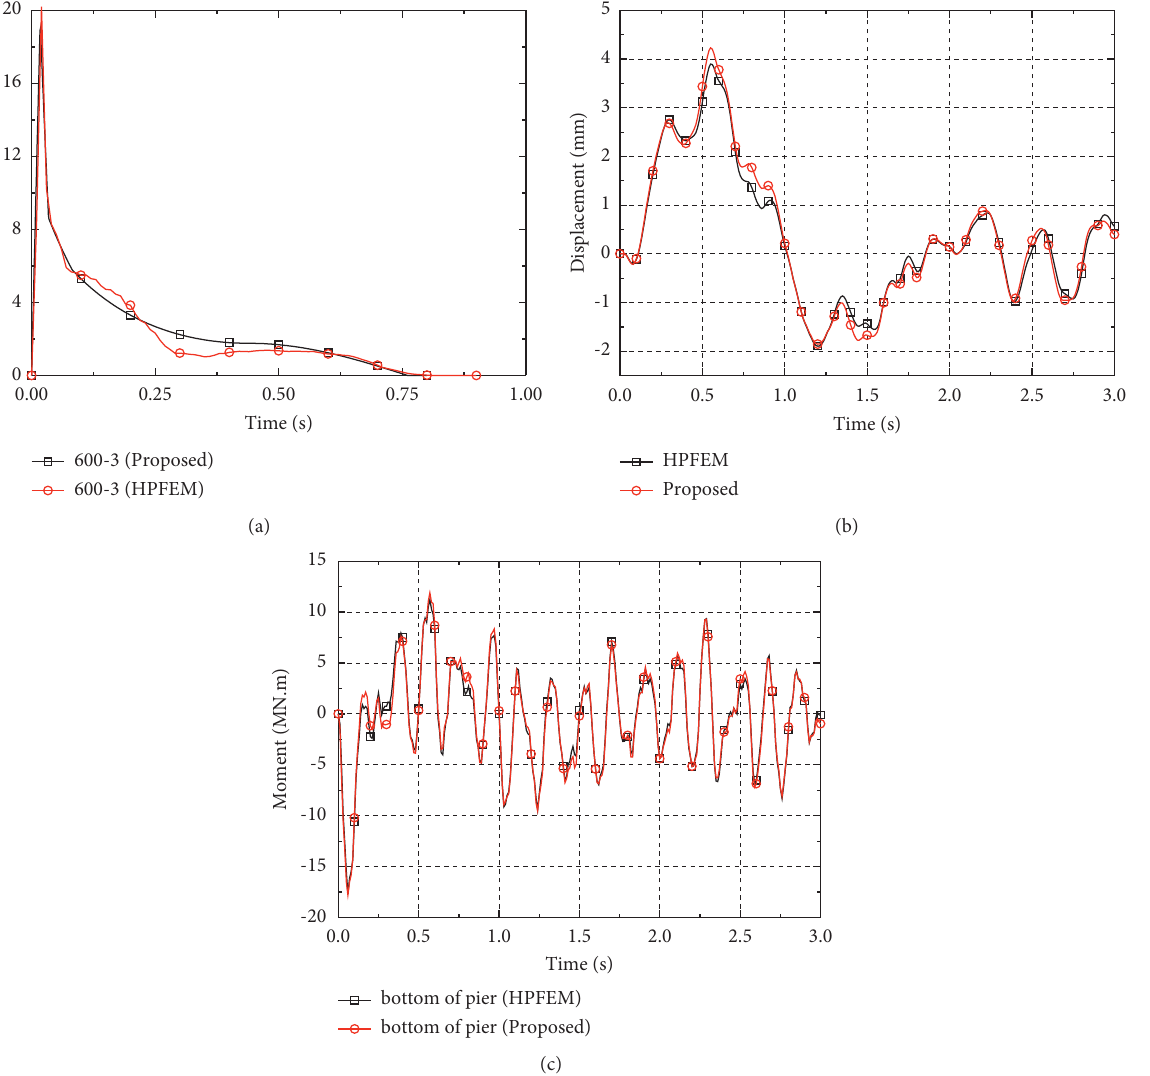
Figure 17: Results of a simulation of a collision by a 600-ton barge at the impact velocity of 3m/s. (a) Time history of impact force (600 t+3 m/s). (b) Time history of displacement of pier top (600 t +3m/s). (c) Time history of moment of pier bottom (600t